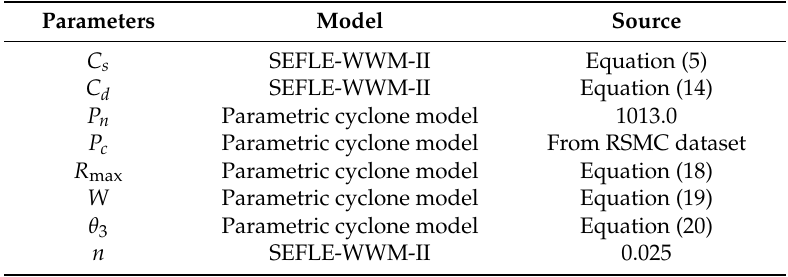
Table 1. The parameters used in SELFE-WWM-II and parametric cyclone